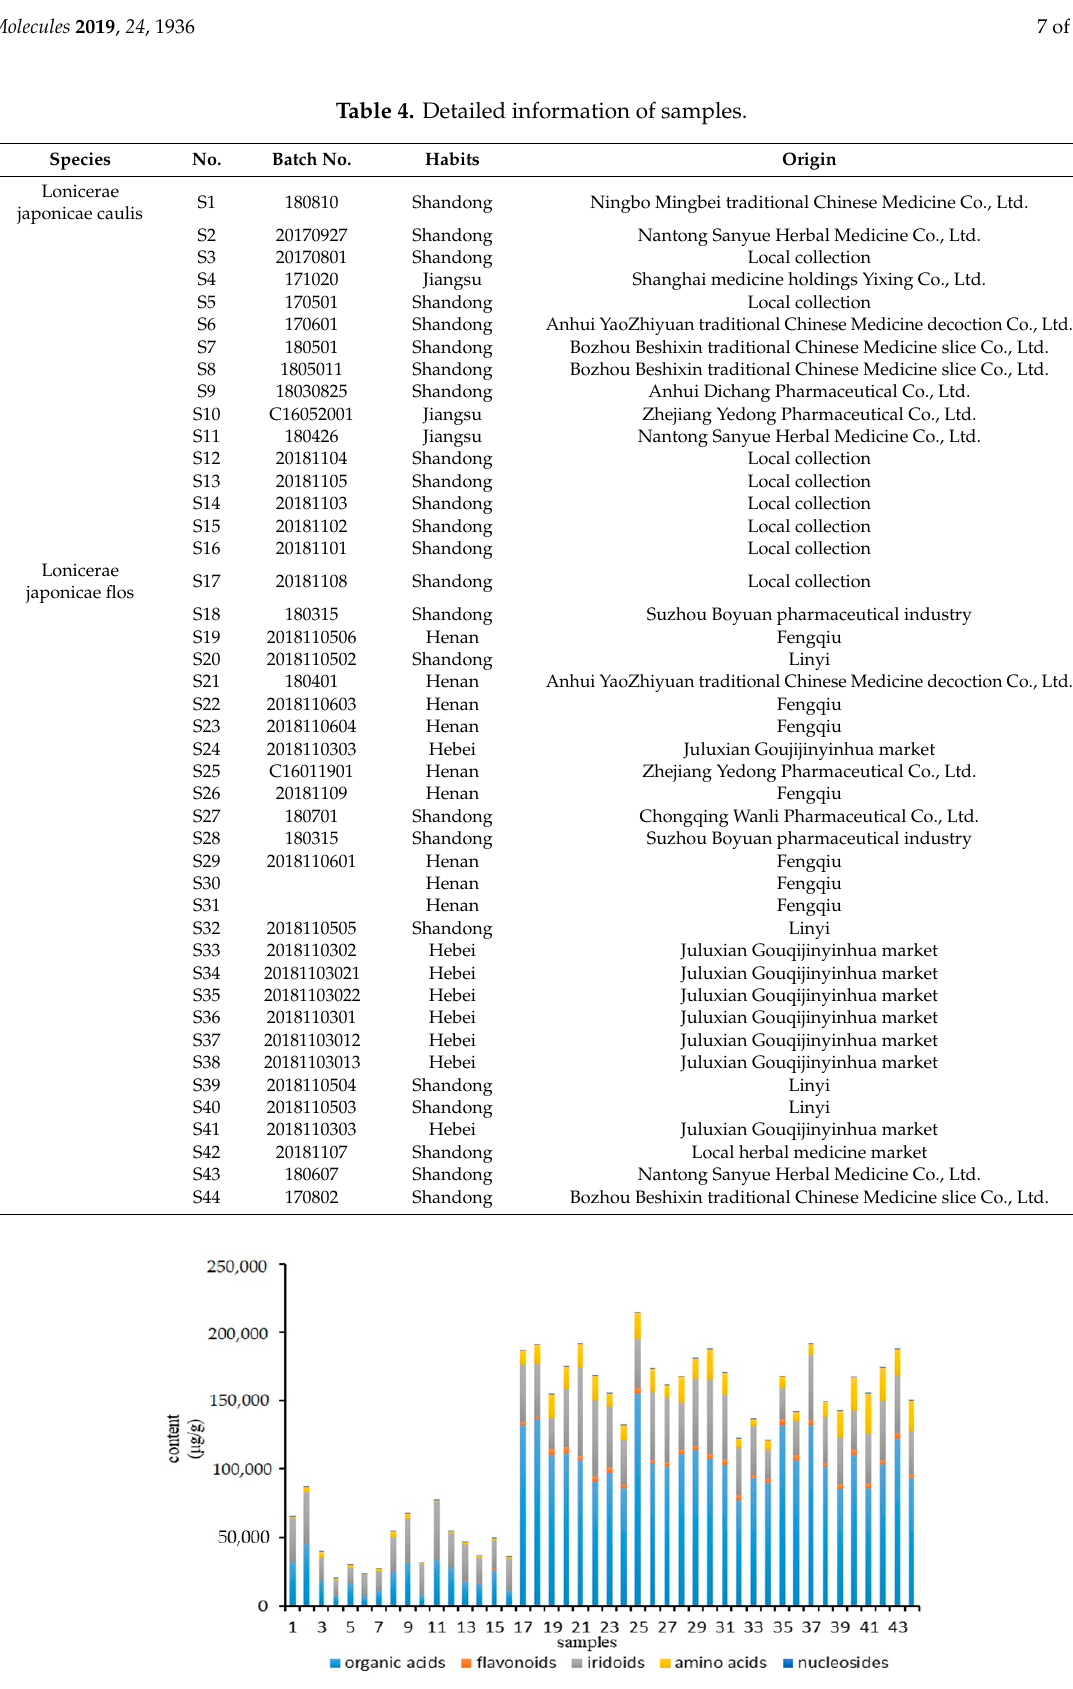
Figure 1. Histogram of the accumulative contents of LJF and LJC from 44 batches ( X -axis represents 44 batches of samples; Y -axis is the content ( µ g / g) of five types of compounds in each sample). Table 3. Detailed information of samples.